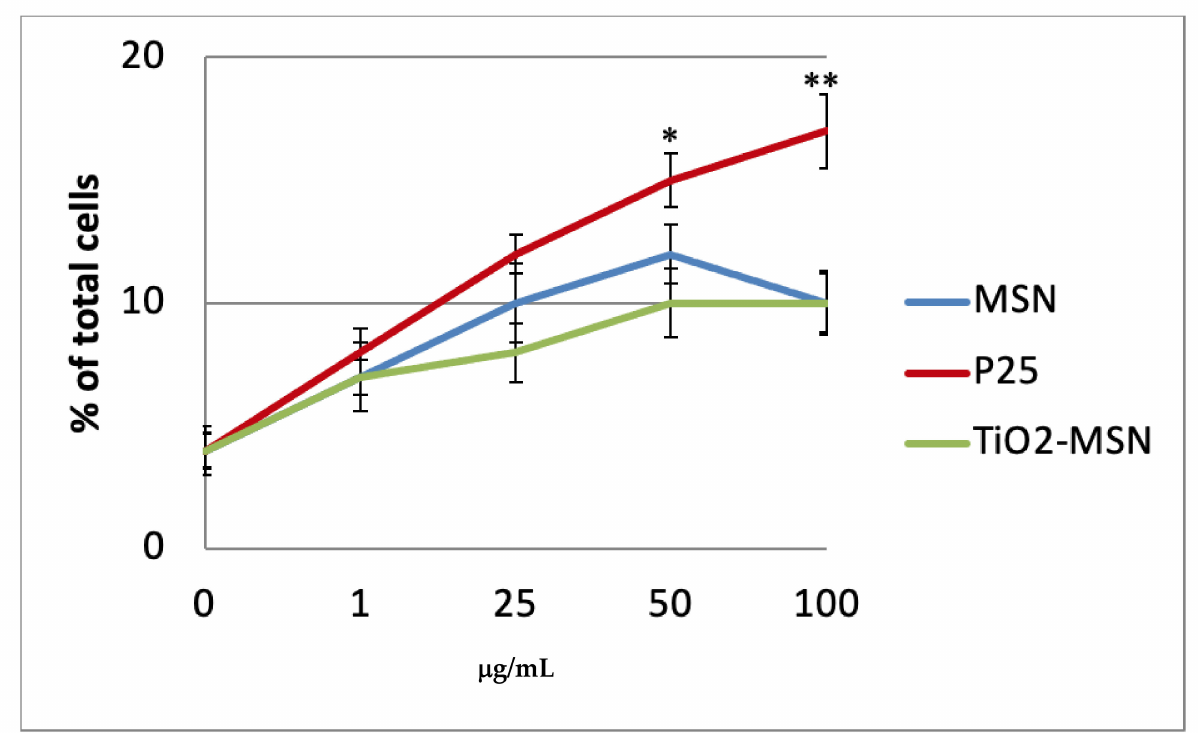
Figure 3. Apoptosis detection of resting peripheral blood mononuclear cells (PBMC) by annexin V staining after 6 h culture without PHA. Significance values: * p < 0.05, ** p < 0.005; error bars represent the standard error of the mean.